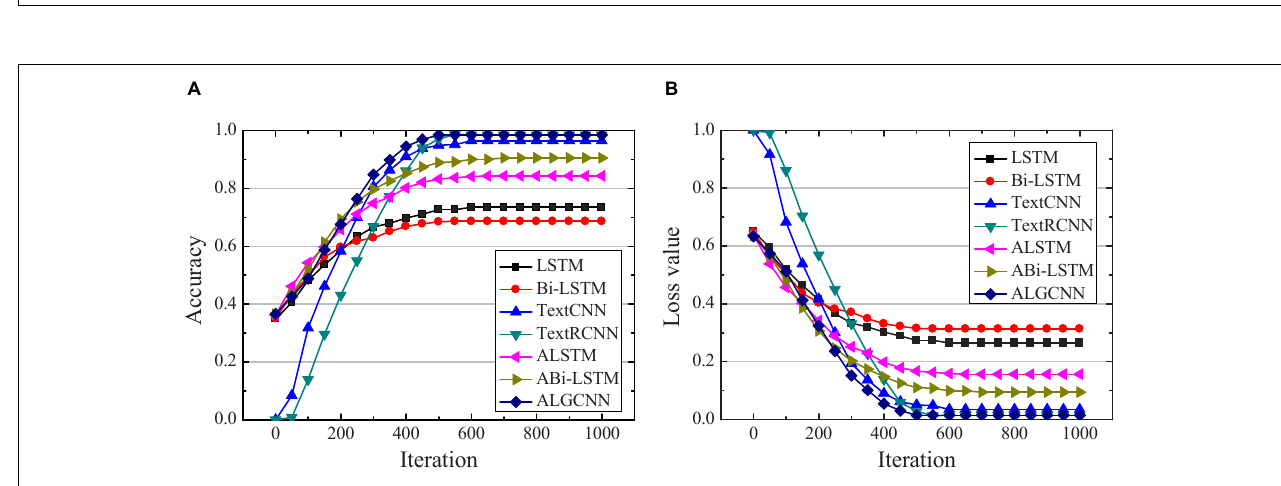
FIGURE 3 | Comparison of classification performance of different models on the MR data set. (A) Is the comparison on classification accuracy; (B) is the comparison of classification loss value.